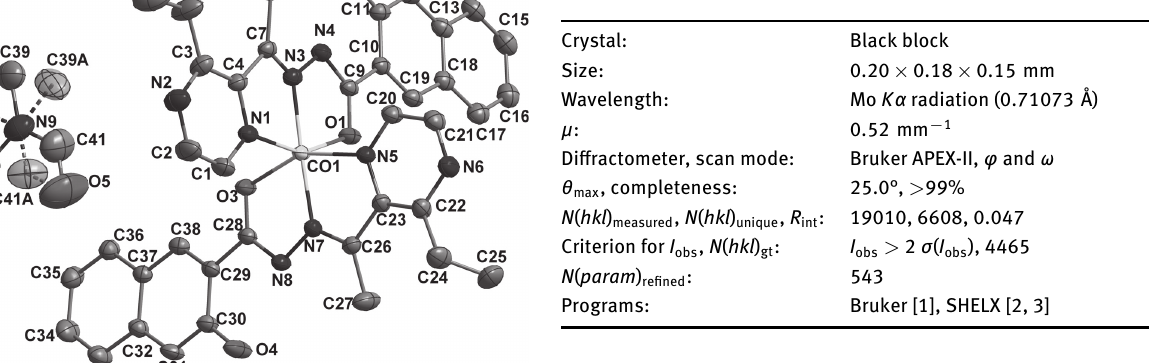
Table 1: Data collection and handling.